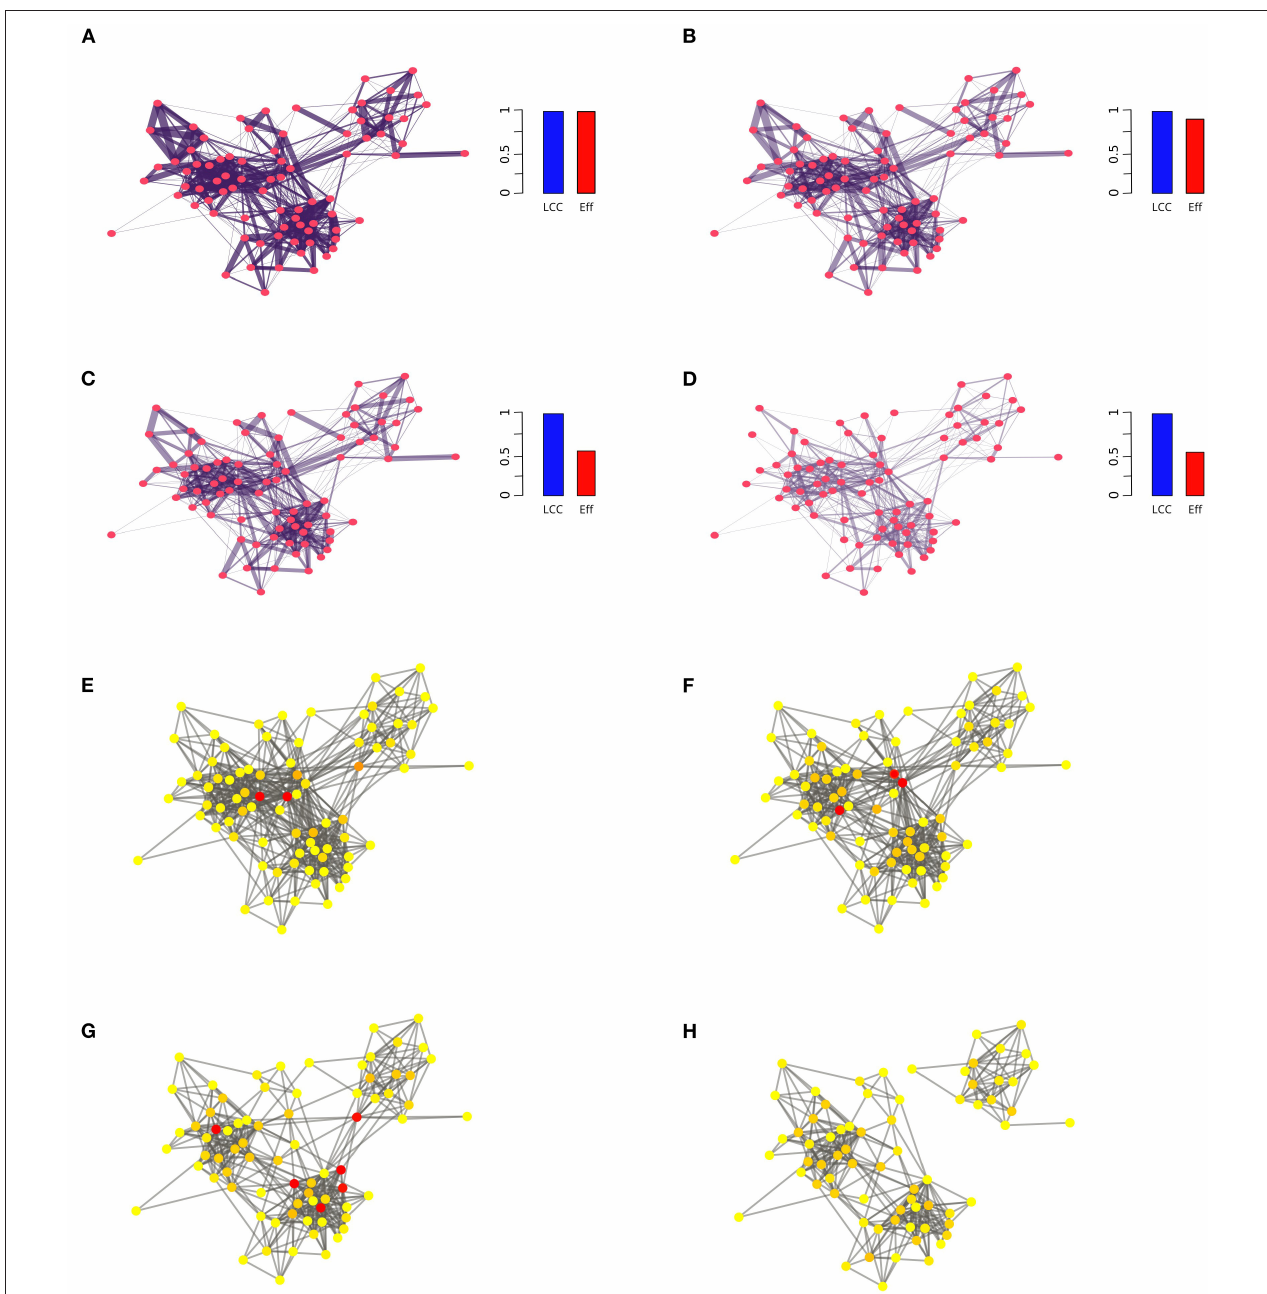
FIGURE 2 | (A–D) Link removal process of the links with the highest weight over the UK faculty friendship social network [41] composed of 81 nodes and 817 links. We progressively remove the strong links in the network to reach the removal of 20% of the total number of links. Strong link removal (thick black lines = strong links) quickly decreases the network efficiency (Eff) with no network node disconnection, e.g., LCC does not decrease. The Eff and LCC measures are normalized by the initial value, e.g., before any removals. Strong link removal may severily slow down the pace of spreading in the network without disconnecting the nodes. (E–H) The UK faculty network subjected to the process of removal of the nodes with highest betweenness centrality (red nodes). The red nodes in each panel represent the nodes removed at each step; the total number of removed nodes is 11. The node removal fragments the network into two isolated components, halting the information spreading among